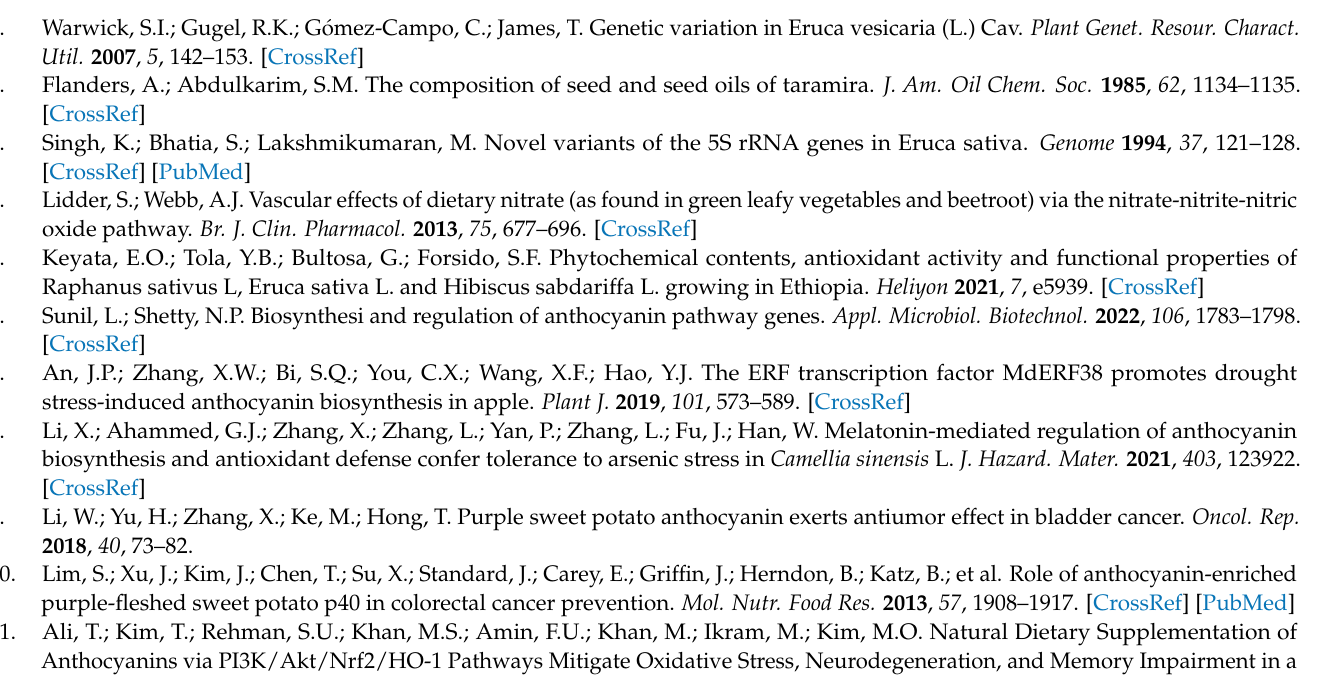
Table S1: Summary of transcriptomic